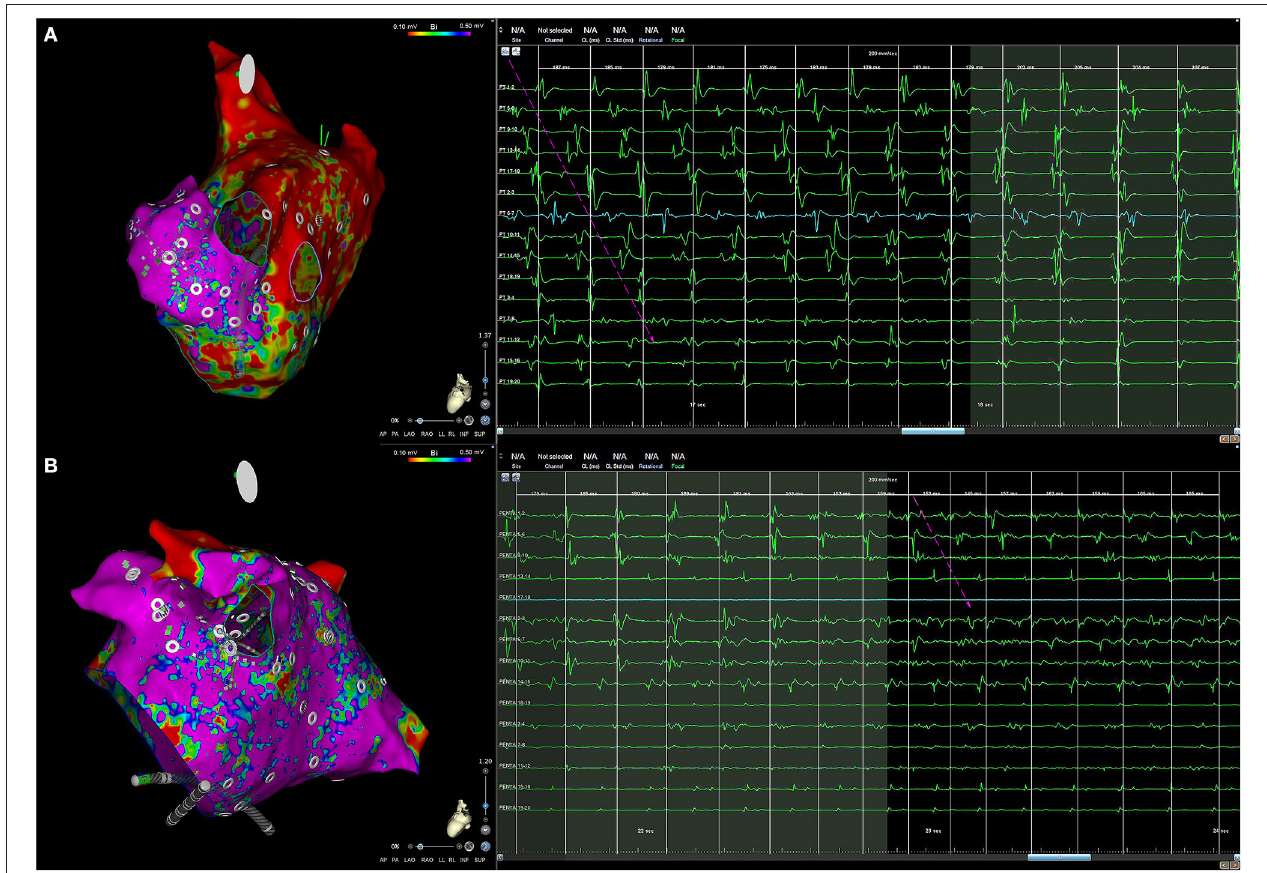
FIGURE 5 | (A) Example of a woman with AF recurrence after PVI. Left: RAc was detected only at the LAA, the remaining atrium had low voltage and RAc was not recorded inside the ablation line. Right: the rotational event expands the whole EGM cycle, highlighted with white arrows. The rotational event stops and the cycle length increases with almost simultaneous EGM activations. (B) Example of a man with no AF recurrence after PVI. The voltage is almost normal in the whole atrium (left), RAc was detected in the left inferior PV antra (right). The rotational event starts at the same time that acceleration of discrete EGMs appears (Penta 13–14 EGM) and fragmentation in middle ring electrodes (from Penta 3–4 to Penta 11–12 EGMs). AF, atrial fibrillation; PVI, pulmonary vein isolation; LAA, left atrial appendage; EGM, electrogram; PV, pulmonary vein.